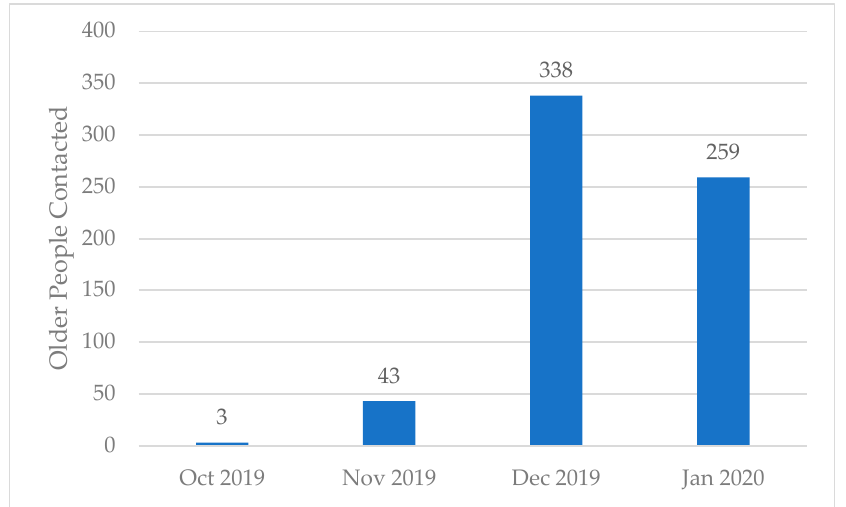
Figure 1. Time in the flu season when individuals were contacted. Note: the usual vaccination season commences in Mid-September in Canada. These individuals were contacted later in the flu-season in order to address vaccine hesitancy among those that had not responded to their initial primary care invitations.